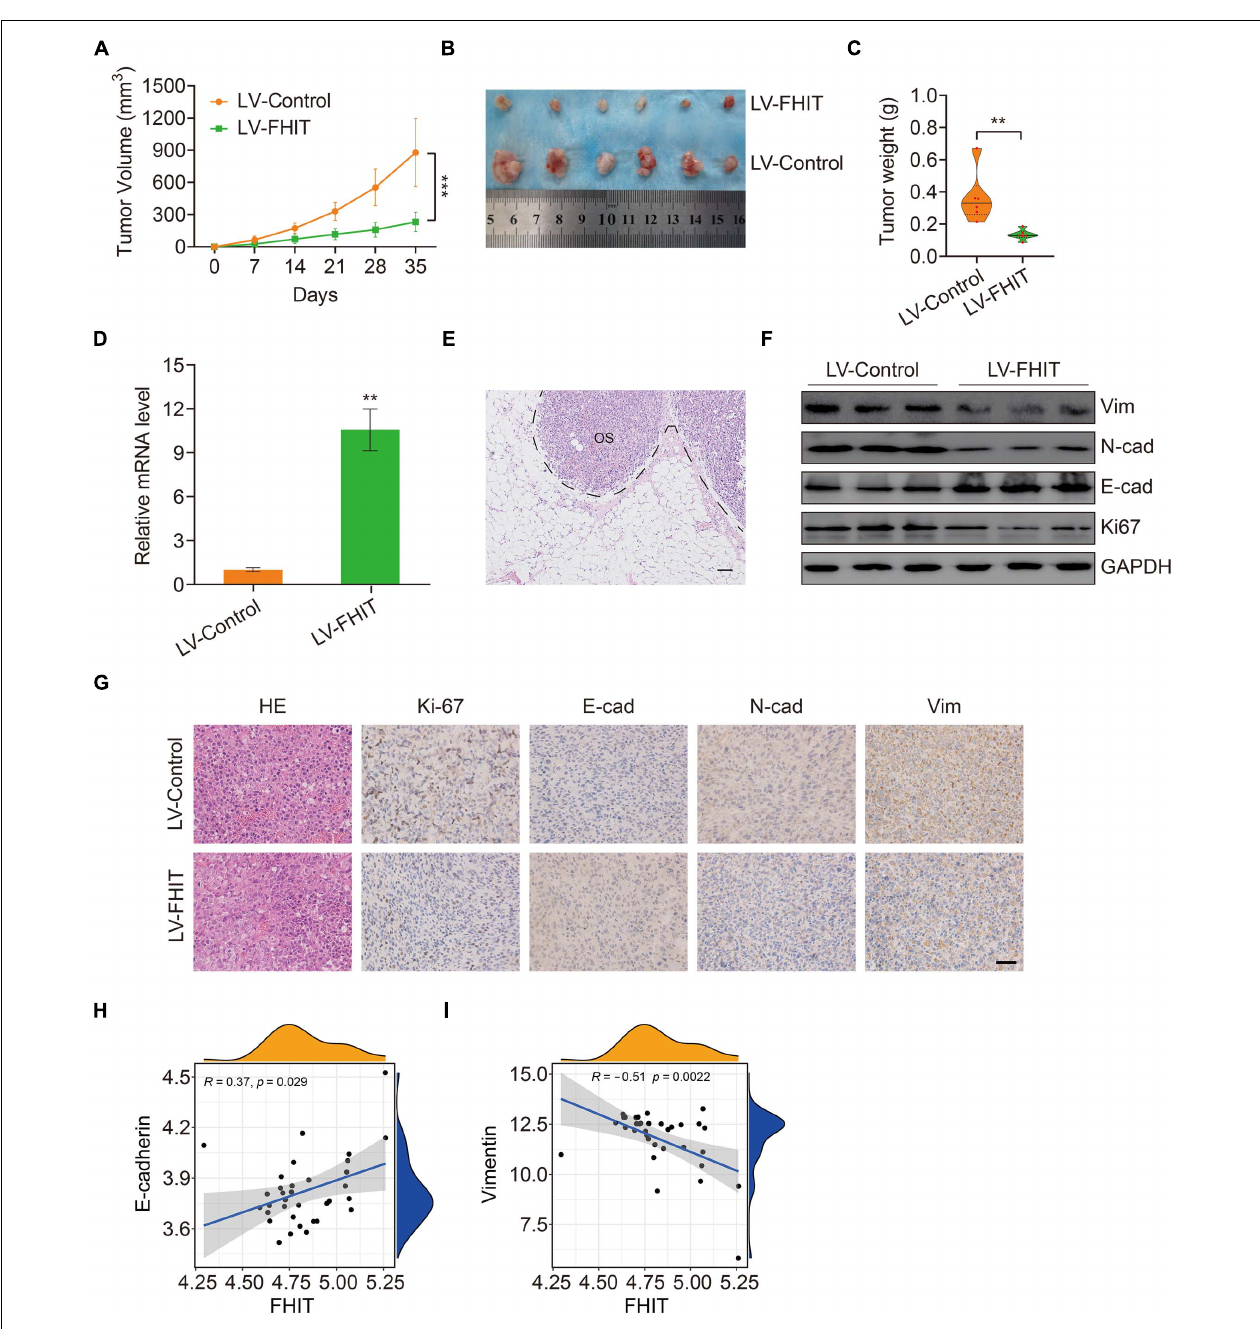
FIGURE 10 | FHIT inhibits tumor growth in vivo . (A) Tumor volumes were monitored every week. (B) Subcutaneous tumors were dissected and photographed after 5 weeks. (C) Tumor weights are shown. (D) qRT-PCR was carried out to quantify the FHIT expression in subcutaneous tumor tissues. (E) Representative image of micro-metastasis in the lung tissues of nude mice injected with LV-Control 143B cells. OS, osteosarcoma. Scale bar, 1 cm. (F) Protein expression levels of vimentin, N-cadherin, E-cadherin, and Ki67 were measured by western blot analysis. (G) Immunohistochemistry analysis of Ki67, E-cadherin, N-cadherin, and vimentin in tumors. Scale bar, 0.5 cm. (H,I) The correlation of FHIT with E-cadherin and vimentin in GSE16091 dataset. ** P < 0.01, *** P < 0.001.